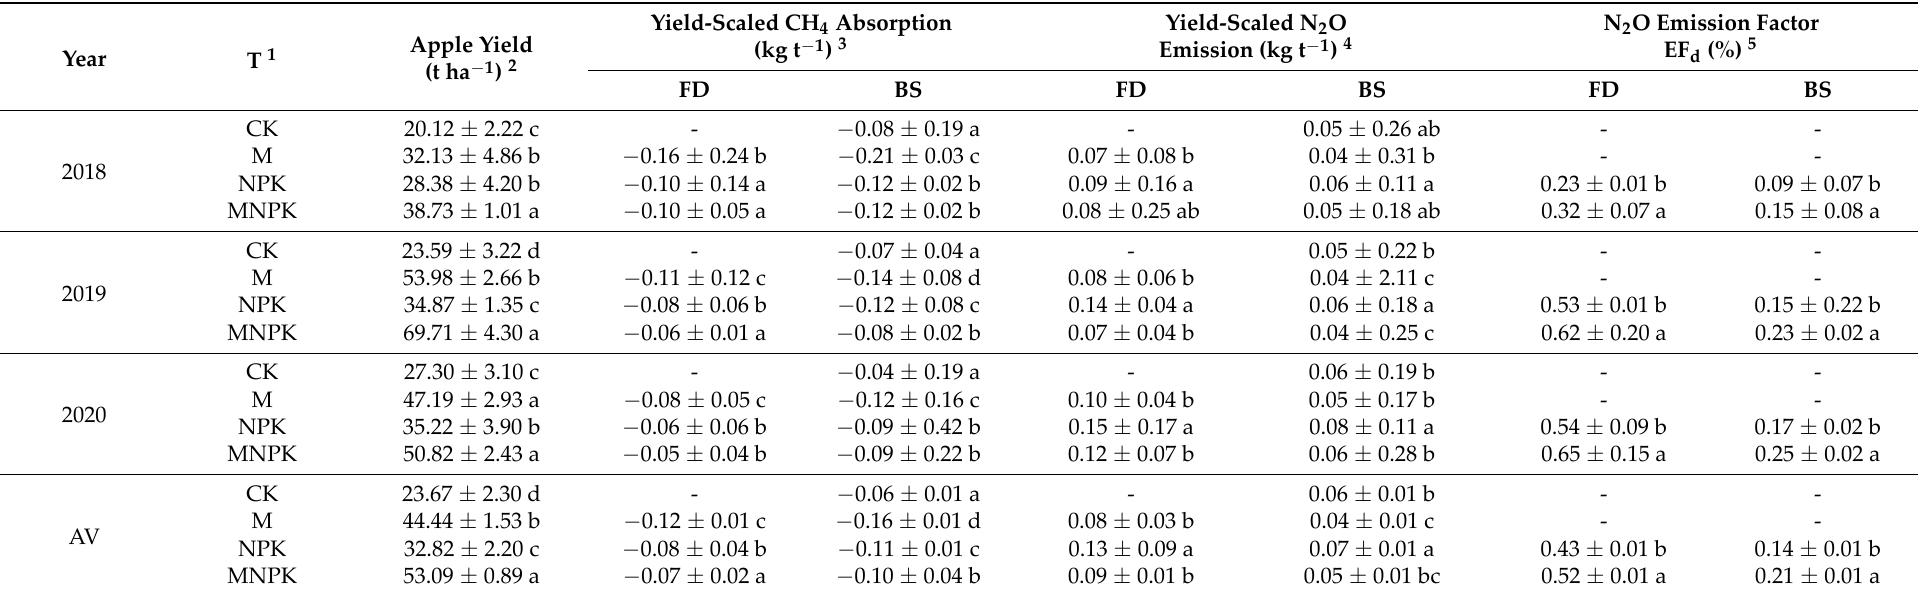
Table 4. Apple Yield, N 2 O EFd, and the yield‑scaled greenhouse gas